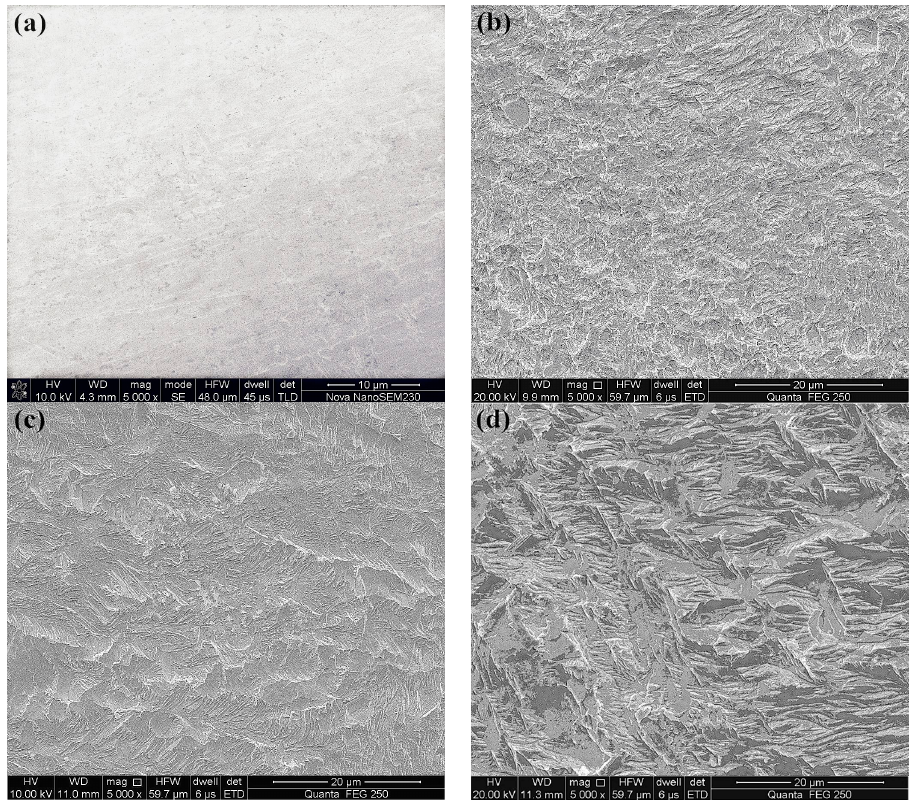
Figure 6. Scanning electron microscopy (SEM) images of gold foils before and after thiosulfate leaching 24 h. ( a ) The original gold foil surface; the leached gold surface of ( b ) in the presence of 10 g/L quartz, ( c ) in the presence of 10 g/L pyrite and ( d ) in the presence of 10 g/L pyrite with the addition of 4 g/L AAPP.